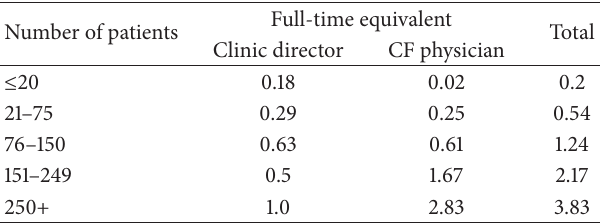
Table 5: Social worker.